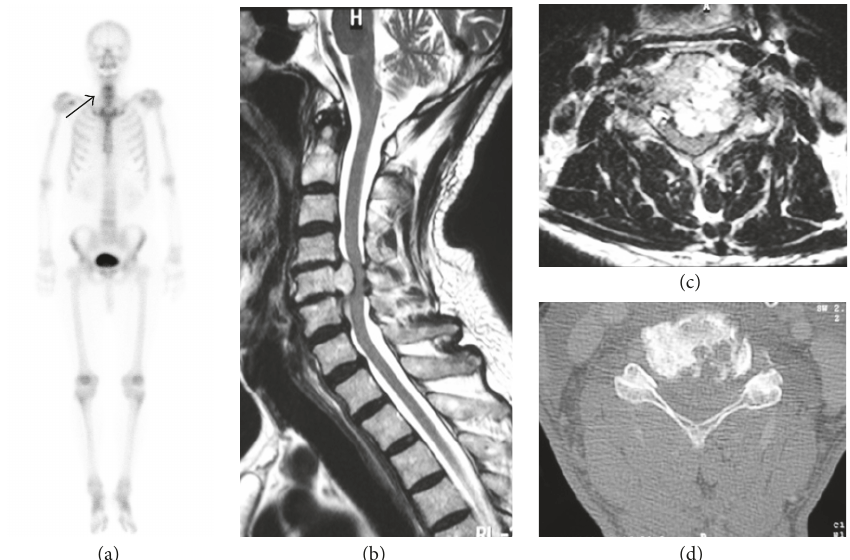
Figure 1: Technetium bone, magnetic resonance imaging (MRI), and computed tomography (CT) scans. (a) Technetium bone scan was useful in localizing the lesion (arrow) and no metastatic lesion was found. (b, c) The MRI scan showed a lesion of increased signal intensity on T2-weighted images in the C5 region, and the tumor is protruding into the spinal canal from the left side of the C5 vertebral body. (d) The CT scan shows the osteolytic lesion in the C5 vertebral